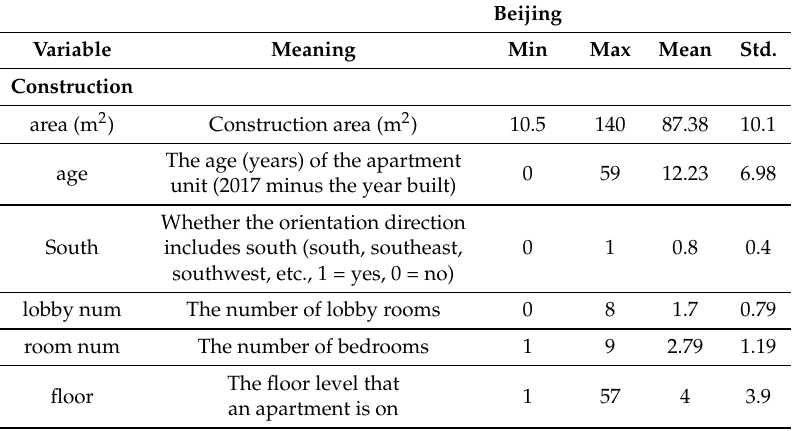
Table A1. Summary of major variables in the collected housing sales